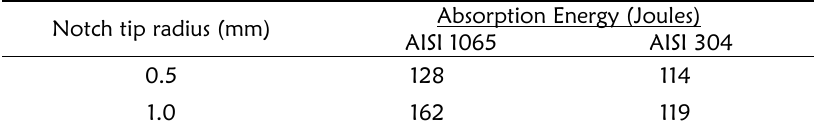
Table 5: Absorption Energy at notch angle of 30°